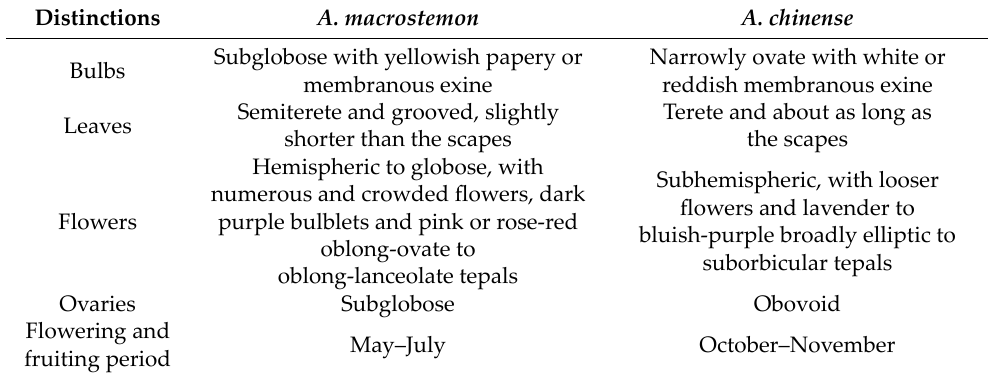
Table 1. Main differences between A. macrostemon and A. chinense in terms of plant morphology.